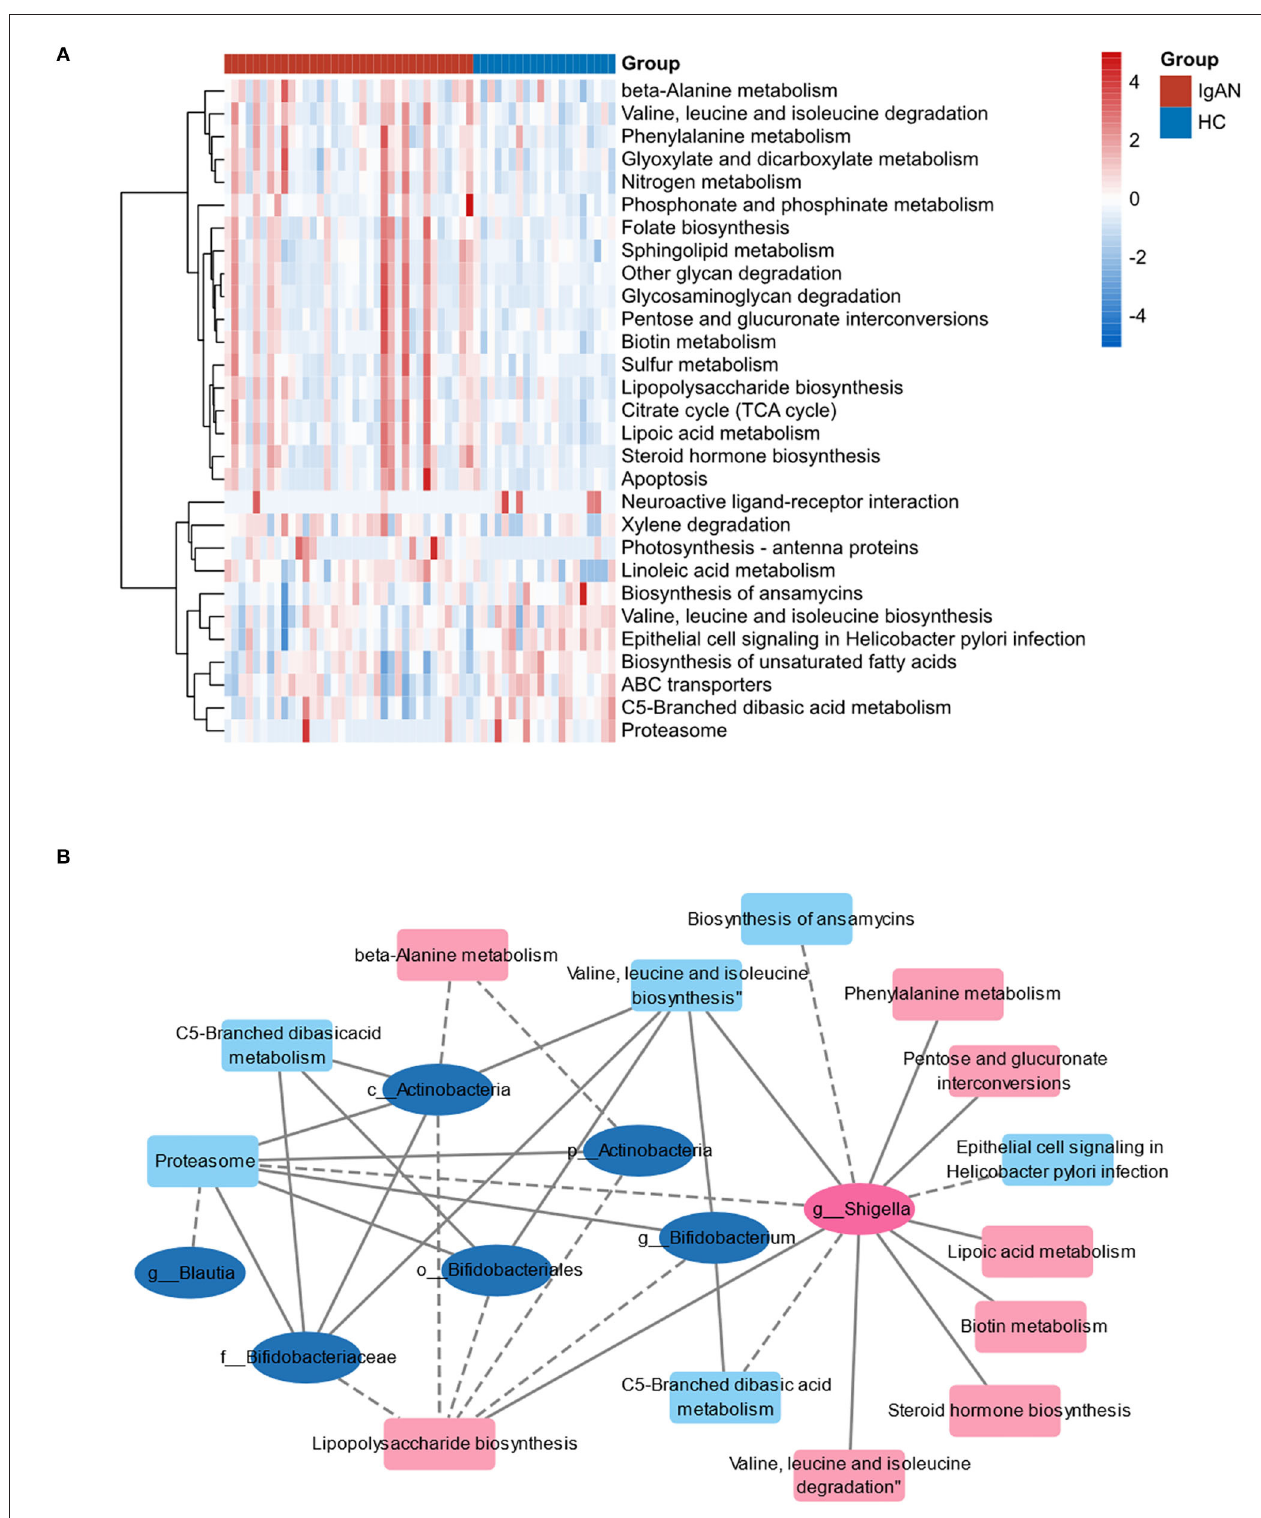
FIGURE 5 | Functional analysis of gut microbiota predicted by PICRUSt2. (A) Heat map of the predictive metabolic pathways of two groups. (B) The correlation network of predictive metabolic pathways and changed microbiome. The ellipses represent the bacteria. The squares represent the metabolic pathways. Pink marks indicate that the bacteria or pathway is upregulated in IgAN and blue marks indicate that they are downregulated. The line between two nodes indicates correlation: the solid line indicates positive correlation, and the dotted line indicates negative correlation.